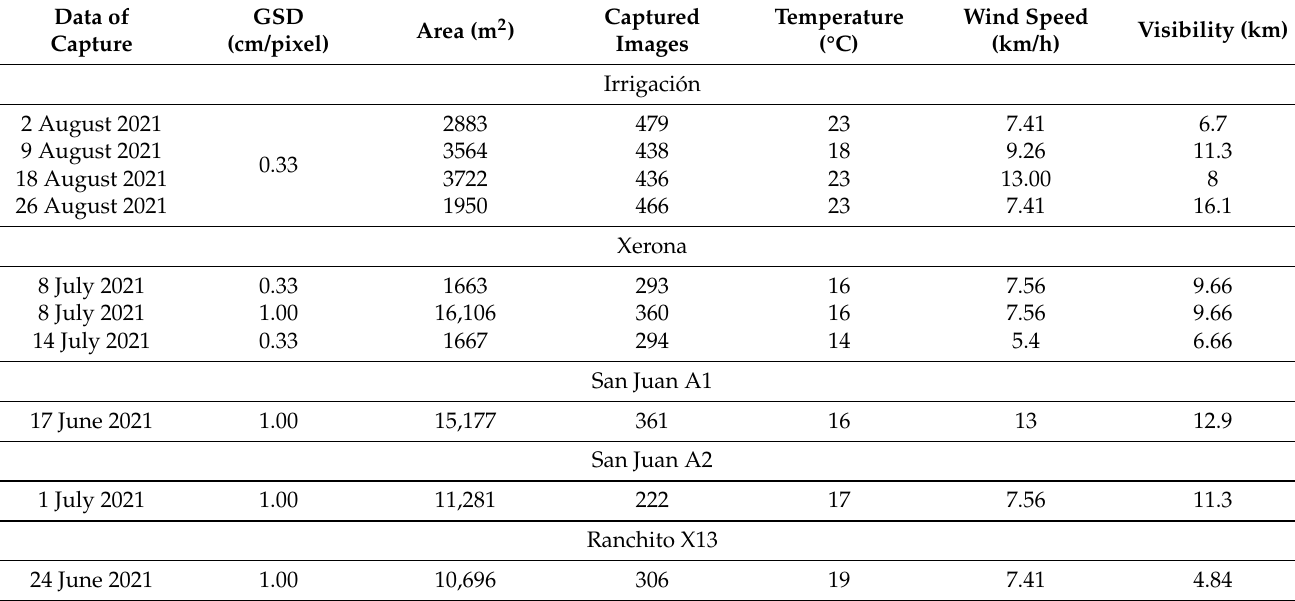
Table 2. Characteristics of flight missions.